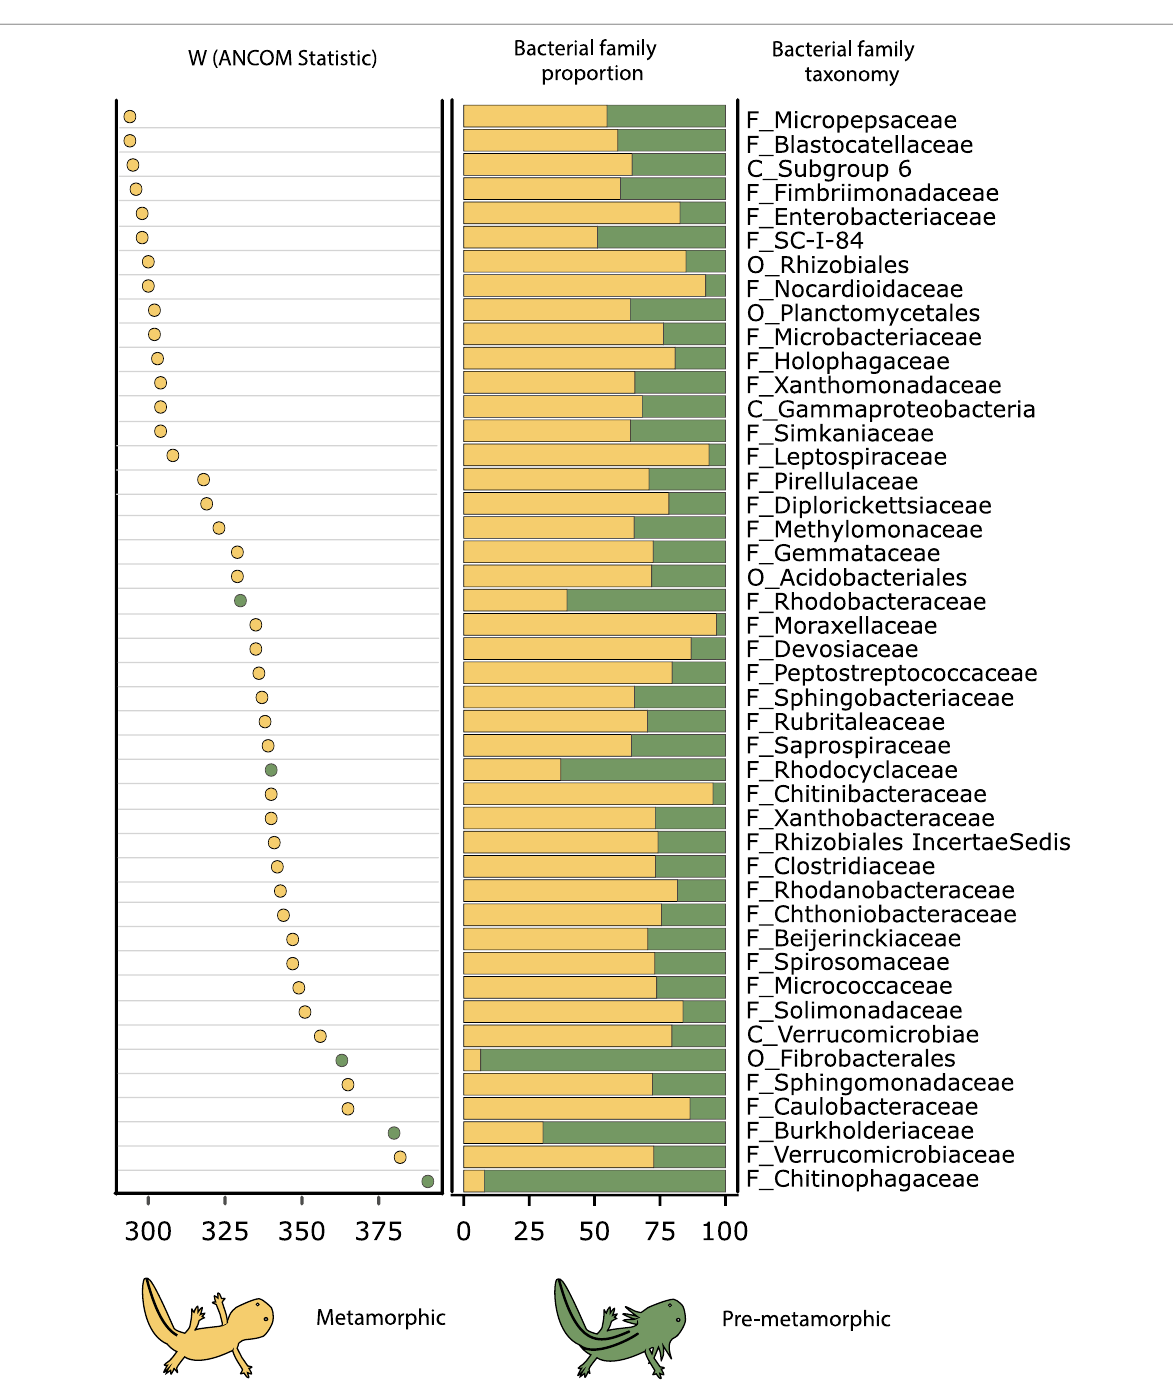
Fig. 2 ANCOM results showing differentially abundant bacterial families between metamorphic and pre‑metamorphic axolotls. Left panel shows ANCOM W values, the middle panel shows the relative proportion for each bacterial family, and the right panel shows the best taxonomic assignments according to the SILVA database at order (O), class (C) or family (F) level. Circles and bars are color‑coded according to the